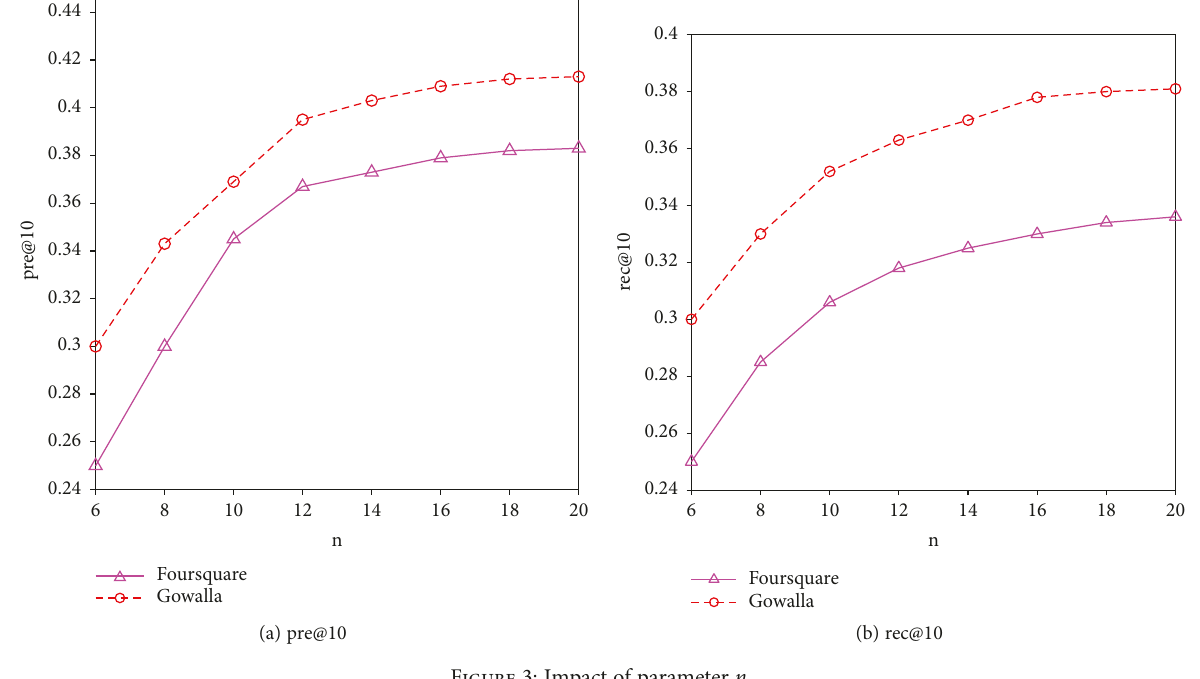
Figure 3: Impact of parameter n .